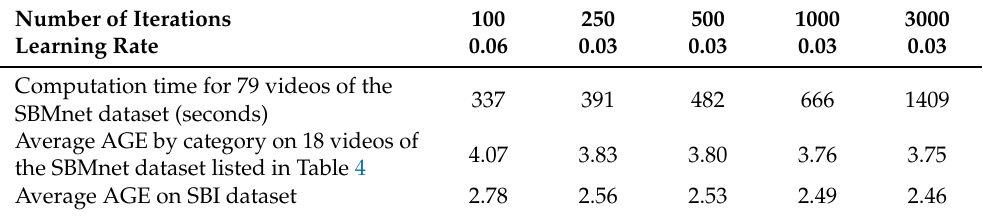
Table 5. Impact of reducing the number of iterations on average AGE score and computation